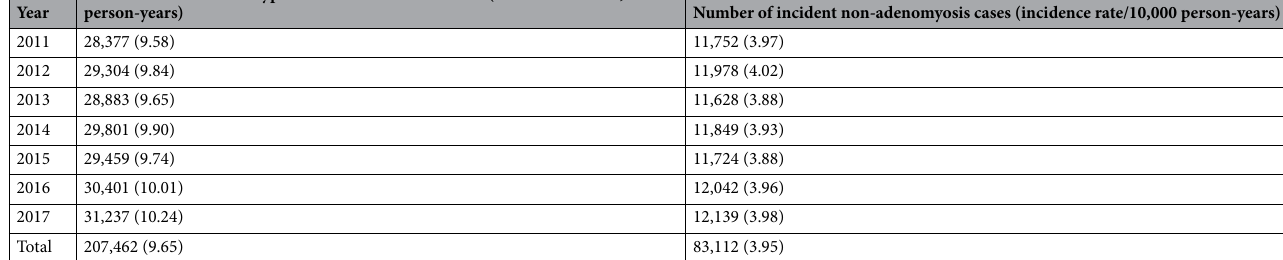
Table 1. Number of incident cases of the main indicator (all-type hospitalized cases coded endometriosis) and the sub-type “non-adenomyosis cases” and their crude incident rate for the study period in the whole of France, in females aged 10 years and above.